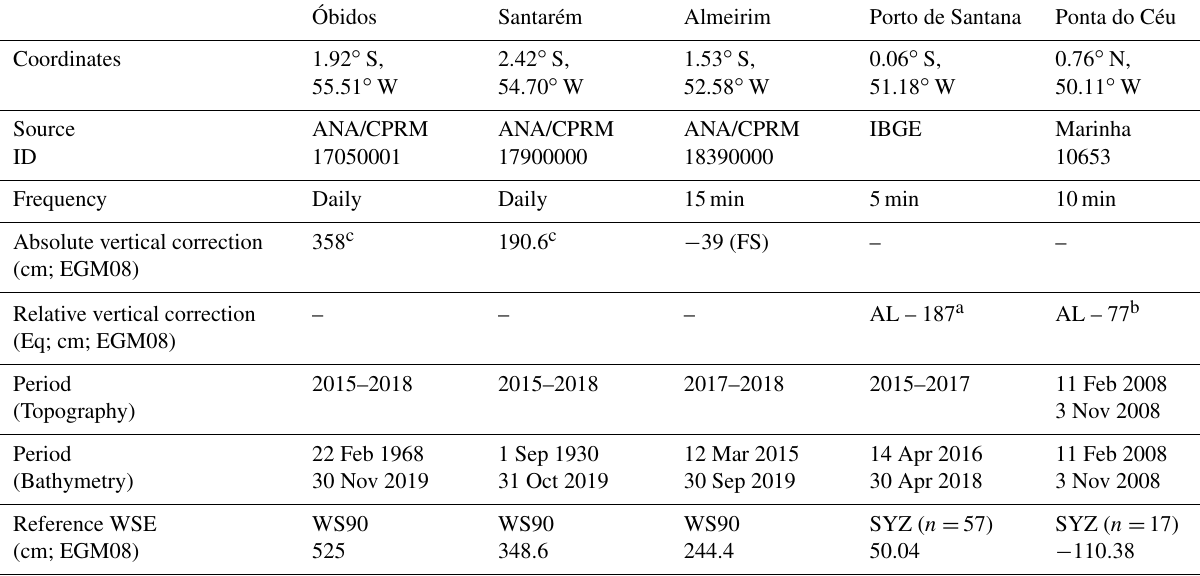
Table A2. Gauge station in the North Channel of the Amazon